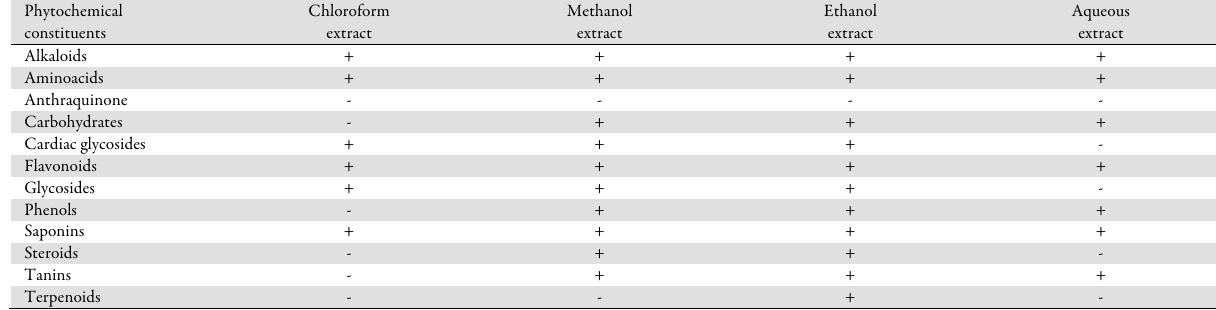
Table 3. Preliminary phytochemical constituents of Abitulon indicum root extracts Phytochemical constituents